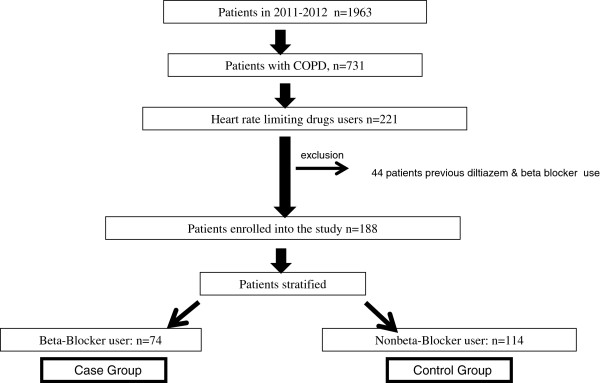
Flow chart of patients enrollment.